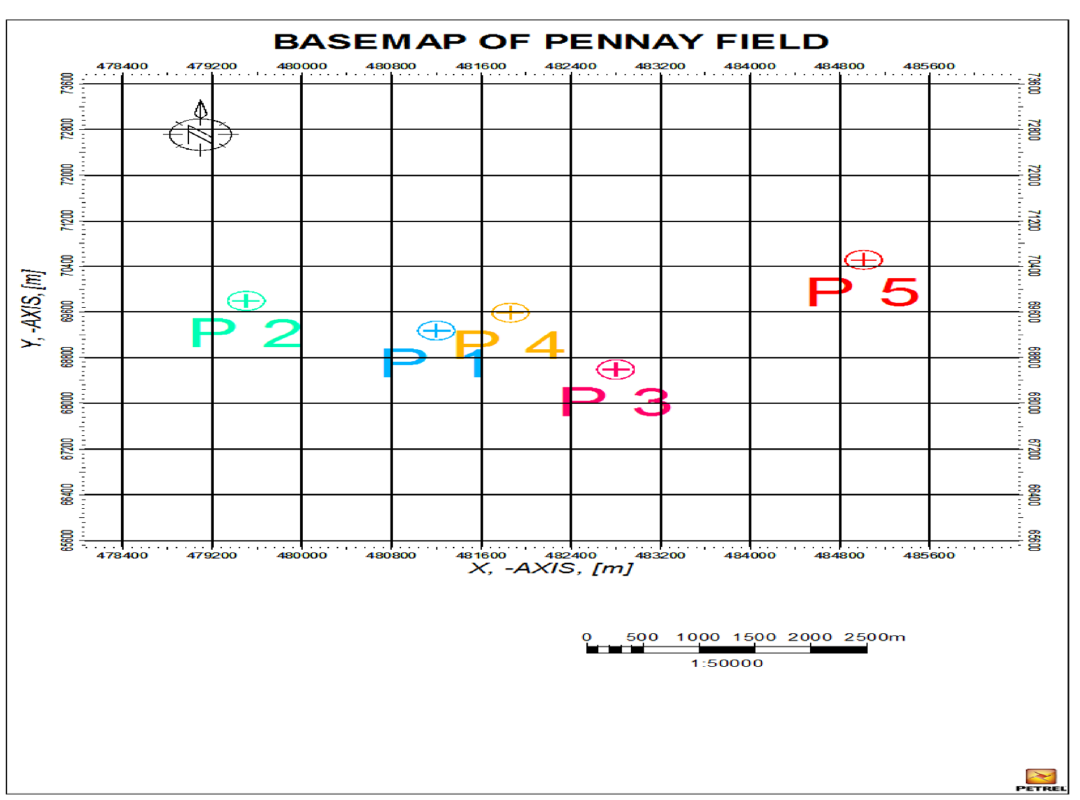
Fig. 1 Base map of the study